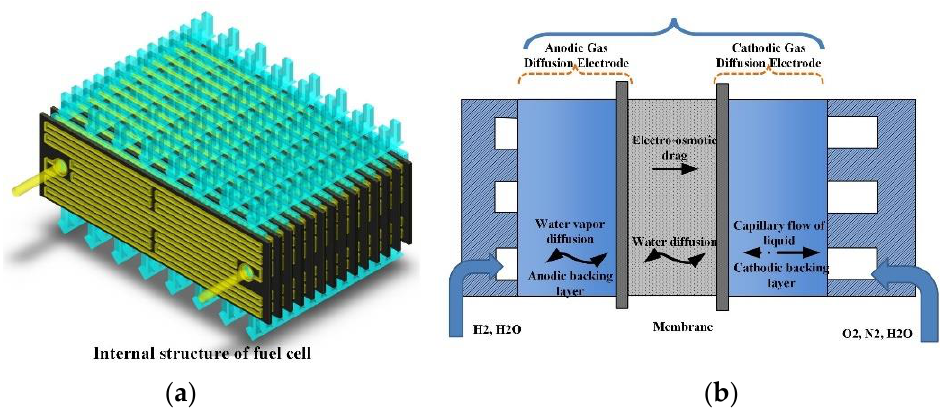
Figure 1. Structure of open-cathode PEM fuel cell: ( a ) anode channel and cathode channel diagram; ( b ) the through-plane configuration of Open-cathode PEM figure.